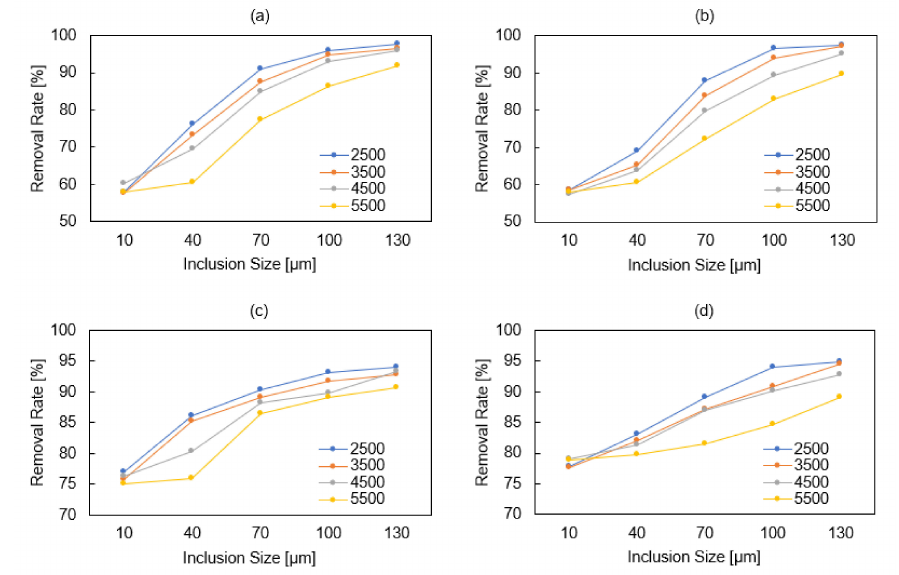
Figure 9. Comparison of inclusion removal rate with change of inclusion density: ( a ) Case 1-W + LD, ( b ) Case 2-W + HD, ( c ) Case 3-W + LD + G, ( d ) Case 4-W + HD +